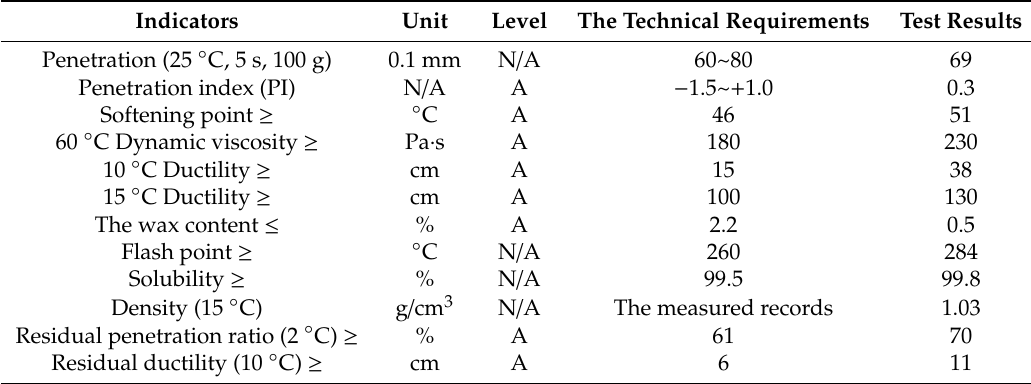
Table 1. Technical properties of No. 70 matrix asphalt.